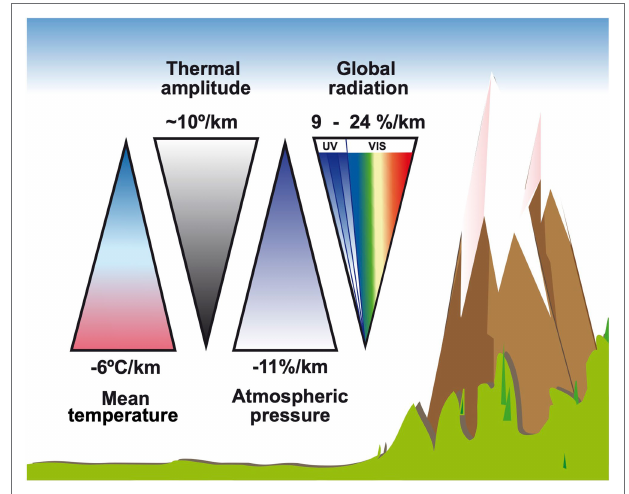
FIGURE 1 | Global climatic parameters as they vary with increasing